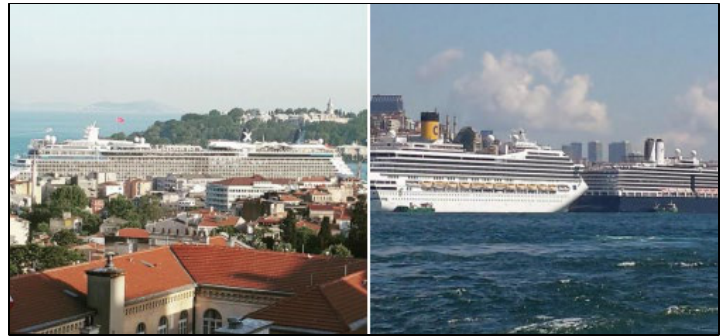
Figure 10 Cruise ships and their impact on the silhouette (Tepeli, 2015).